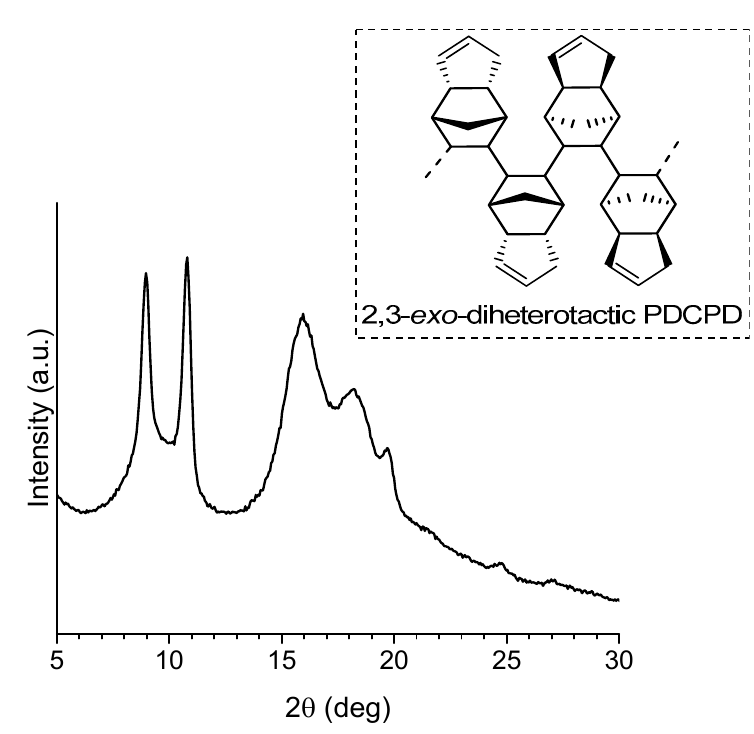
Figure 8. X ‐ ray powder diffraction profile of entry 6. Figure 8. X-ray powder diffraction profile of entry